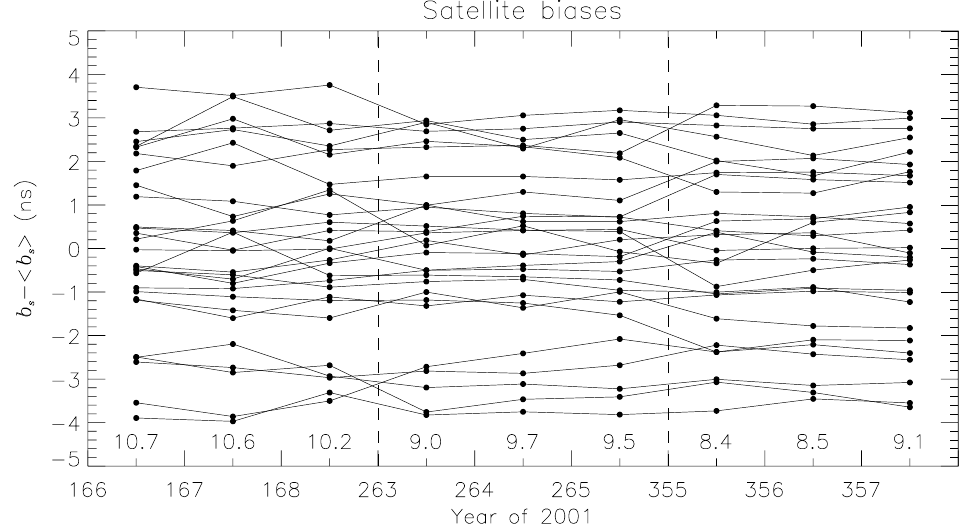
Fig. 3. GEONET derived satellite biases for 9 days over a six-month time span, where the relative bias referring to the bias with the mean of the day removed is shown. The mean of the satellite biases are shown in the lower part of the panel. Vertical dashed lines divide inconsecutive